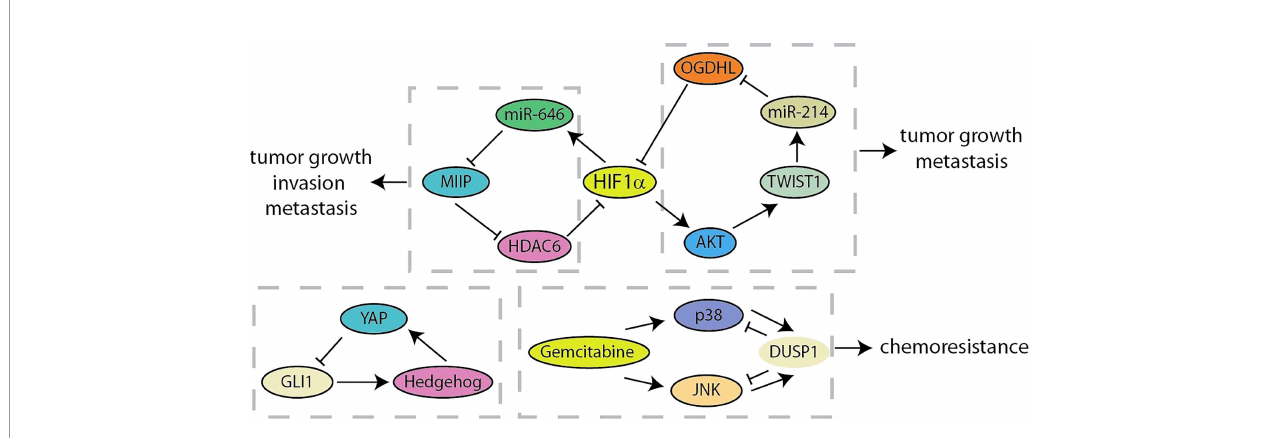
FIGURE 7 | Summary of negative feedback loops in pancreatic